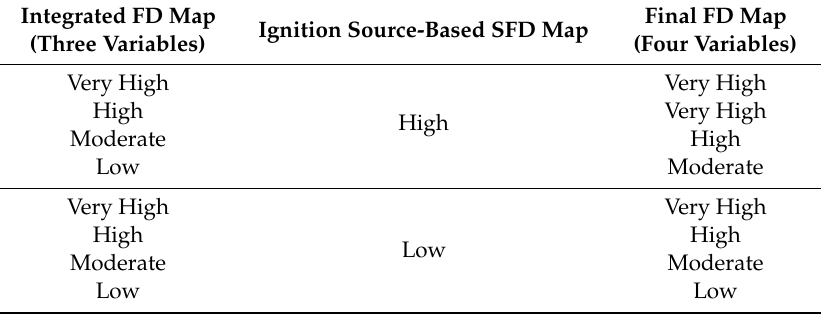
Table 4. Reassigning the FD classes for deriving the final FD map of the four-day FFDFS model with four variables by integrating the fourth variable (i.e., human-caused ignition source) with the integrated FD map.